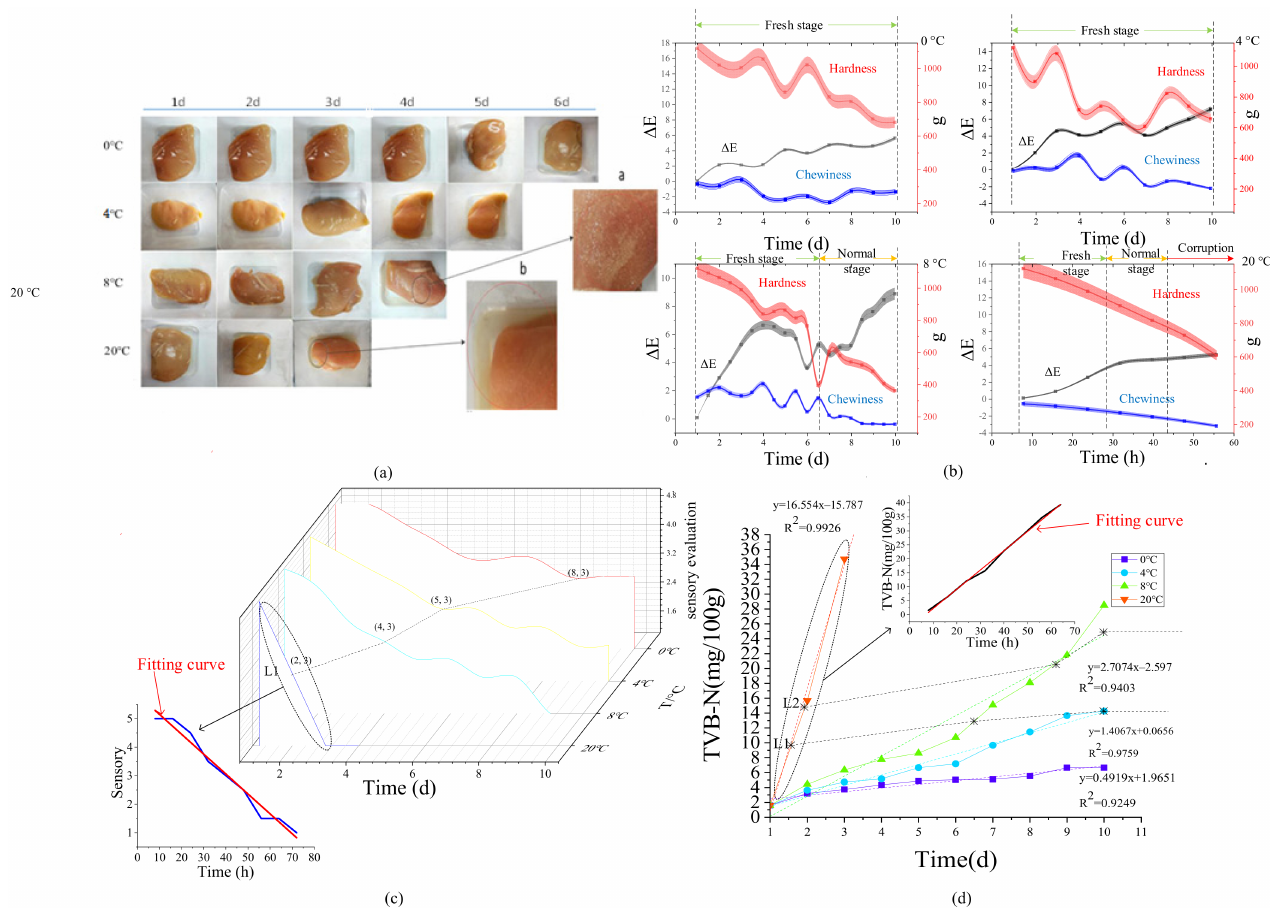
Figure 5. Different quality characteristics of chilled chicken. ( a ) Color Change; ( b ) TPA (color, hardness, and chewiness) changes at different temperatures; ( c ) Sensory evaluation; ( d )